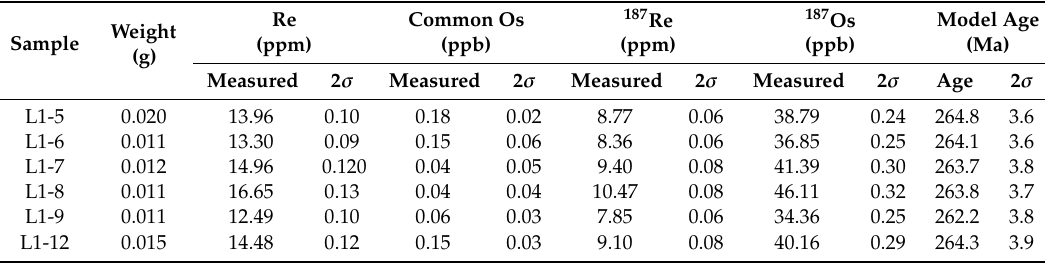
Table 1. Molybdenite Re-Os isotopic data for the Lyangar W-Mo